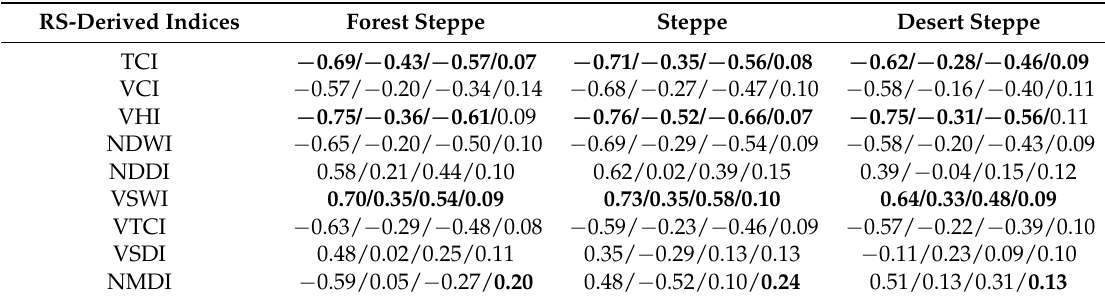
Table 3. R of the PED and satellite-based drought indices during the grass growing period (June–August) across stations (with a 99% confidence level). RS-Derived Indices Forest Steppe Steppe Desert